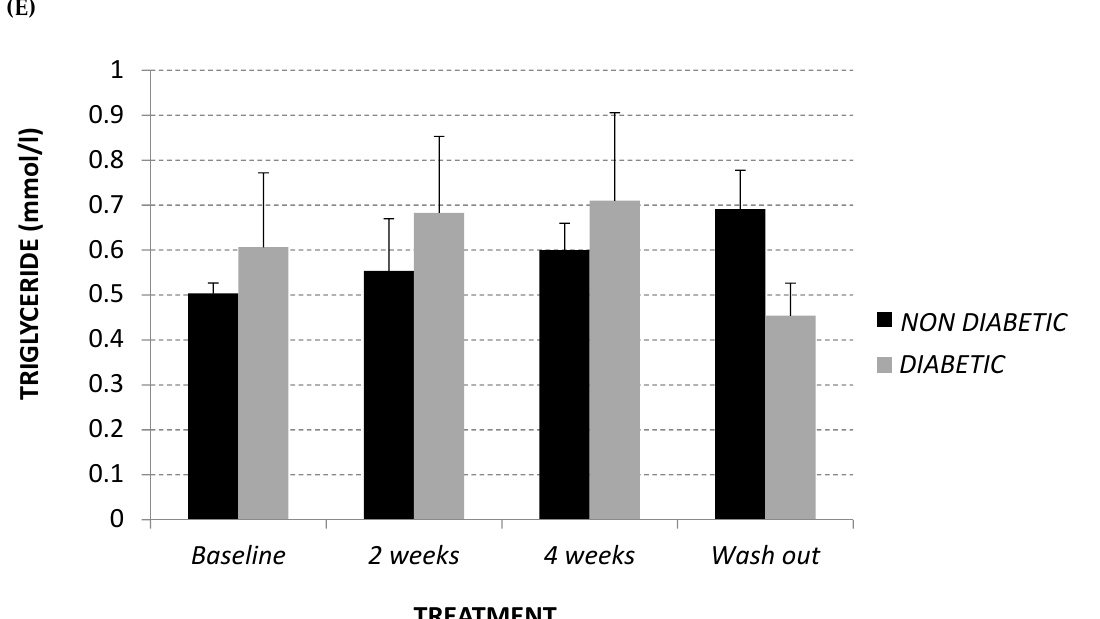
Figure 1. Plasma total cholesterol ( A ), LDL ( B ), HDL ( C ) (mmol/L), LDL/HDL ratio ( D ) and triglyceride (mmol/L) ( E ) at baseline, after 2 and 4 weeks of Afriplex GRT treatment, and following 4 weeks wash-out in non-diabetic (black) and diabetic (grey) vervet monkeys. * p < 0.05, ** p < 0.01 comparing different time points within each experimental group (a = baseline, b = 2 weeks-treatment, c = 4 weeks-treatment); # p < 0.05 and ## p < 0.01 comparing both population groups for the same experimental point. a = baseline, b = 2 weeks-treatment, c = 4 weeks-treatment.